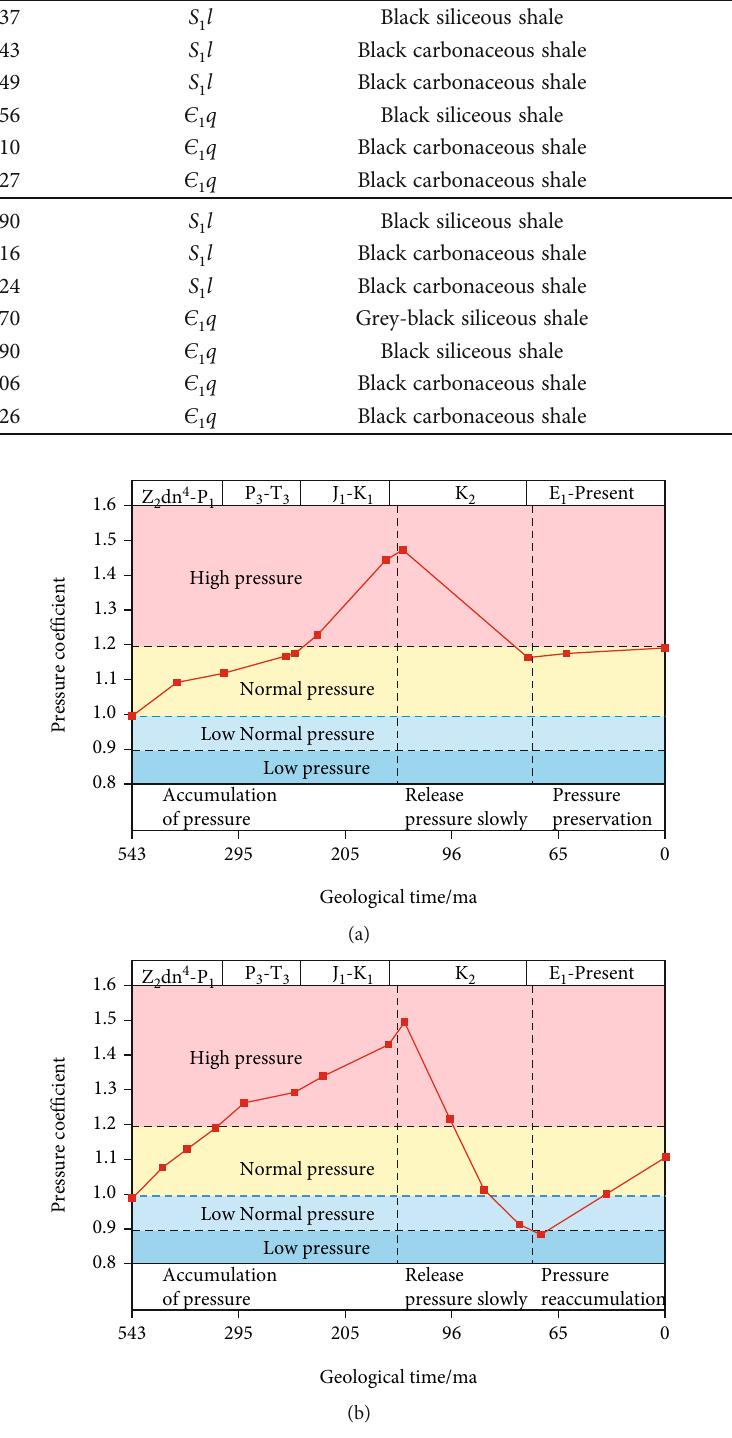
Figure 10: Palaeo-pressure evolution histories of the Z pressure palaeo-gas reservoir (i.e., pressure coefficient > 1 : 5 ) before the Late Cretaceous period followed by di ff erent processes in the